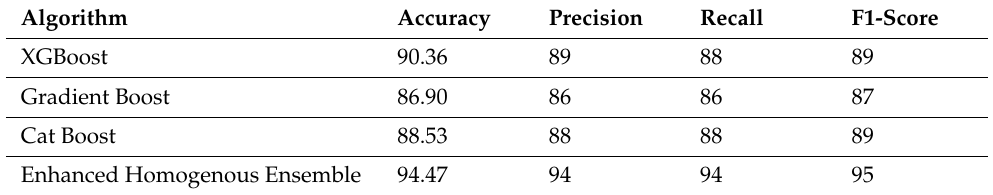
Table 4. Evaluation performance of classifiers algorithms models before EGA feature